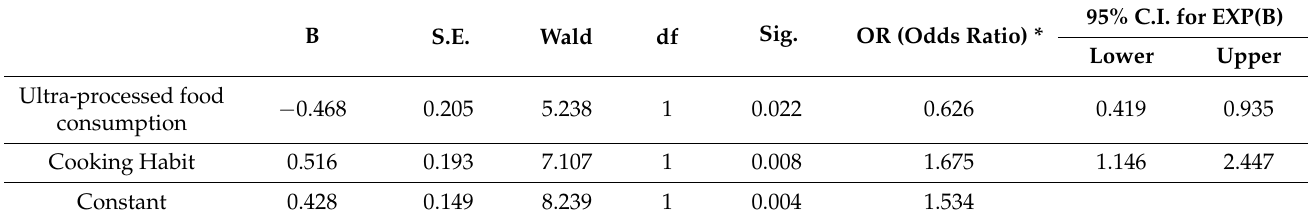
Table 4. Binomial logistic regression between adherence to carbohydrate counting, consumption of ultra-processed foods, and cooking habits by adults with type 1 diabetes mellitus during social distancing due to the COVID-19 pandemic in Brazil, July